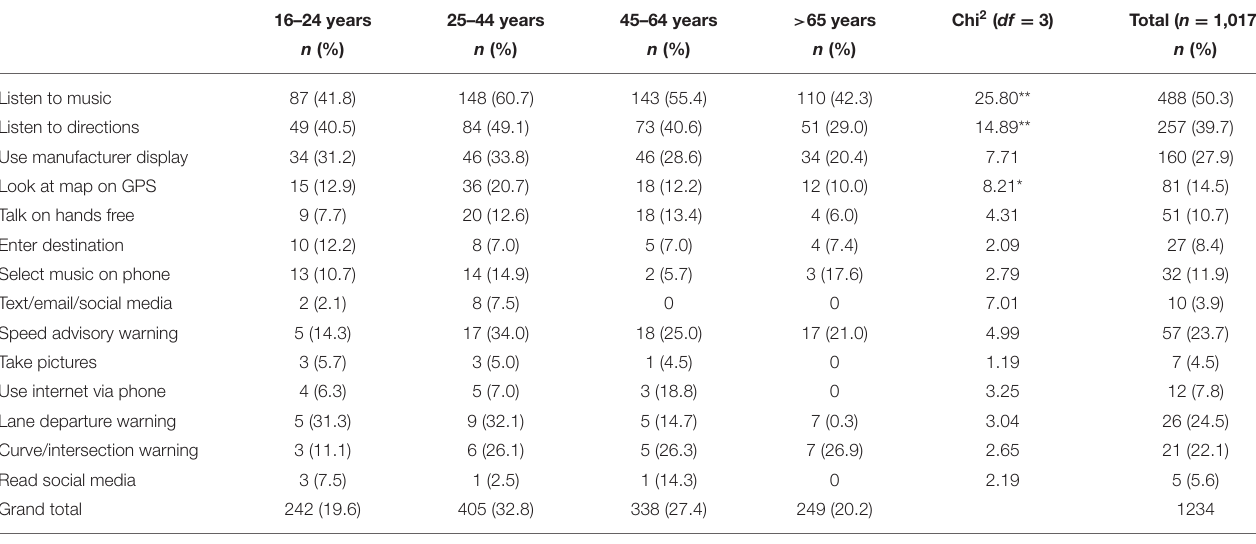
TABLE 8 | The number and percentage of respondents in each age group engaging in each IVIS behavior or event reporting that they used no countermeasures.